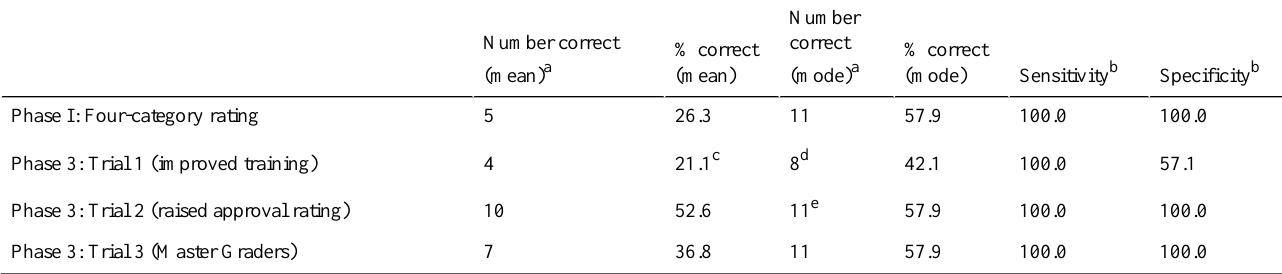
Table 3. Turker consensus in Phase